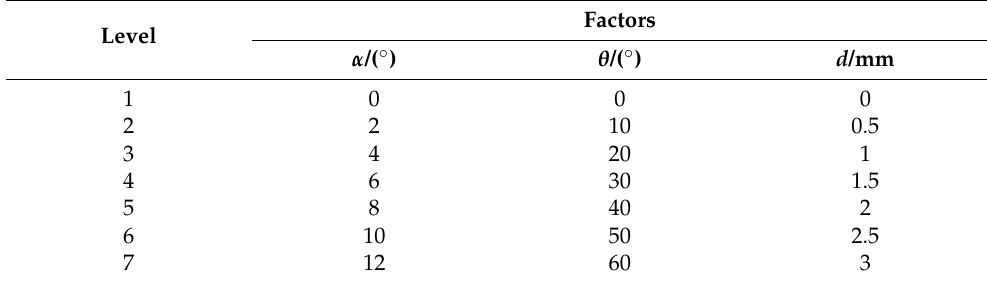
Table 1. Factors and levels of single factor